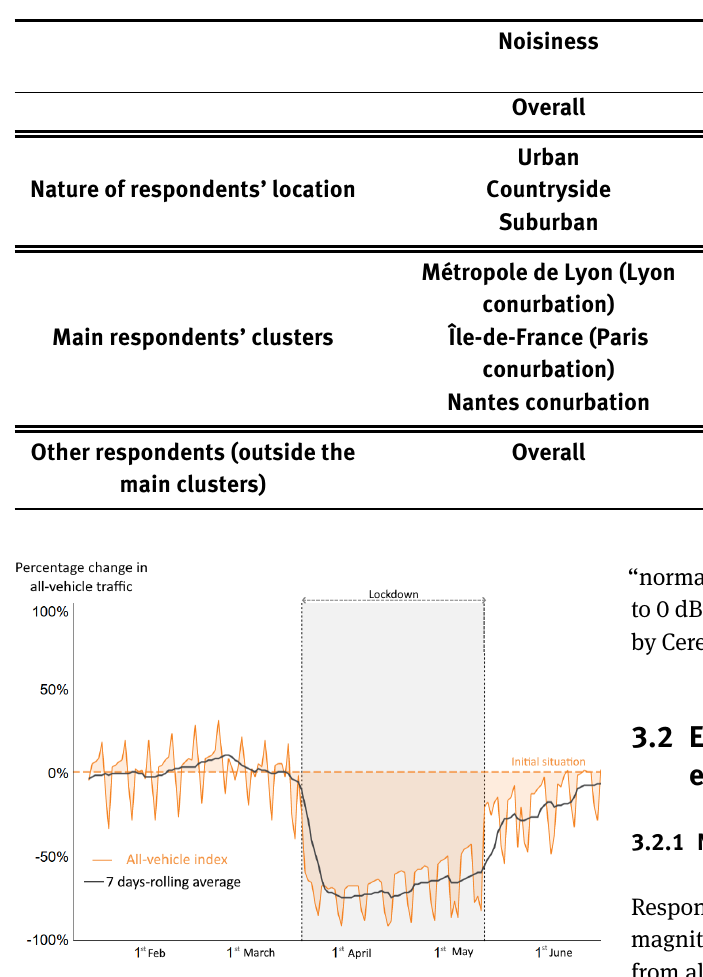
Figure 8: Traflc data from Cerema⁵ showing the evolution. The lockdown period is highlighted in grey